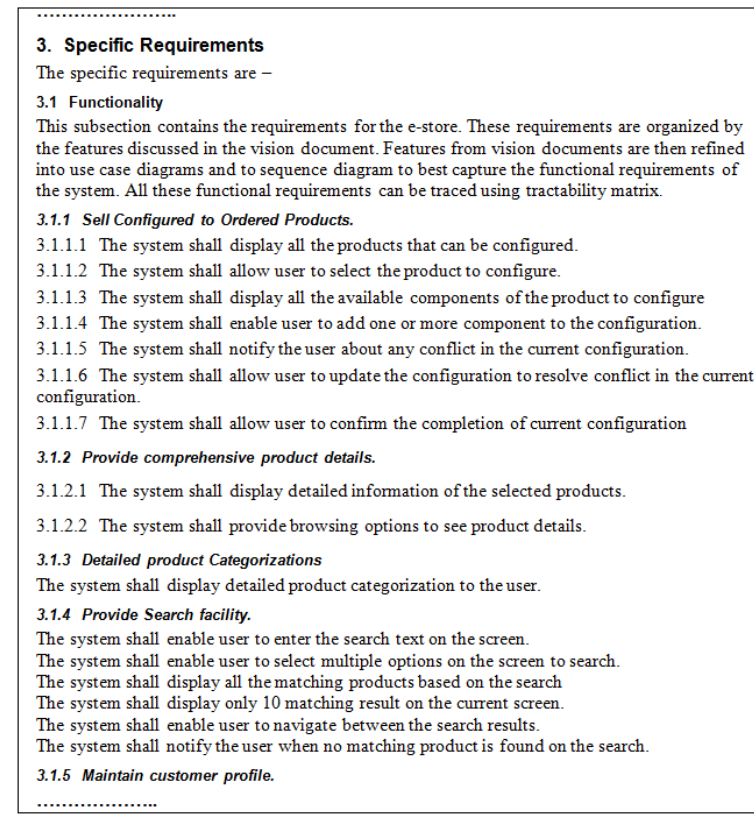
Figure 1. List of functional requirements and their corresponding clusters of an E-Store